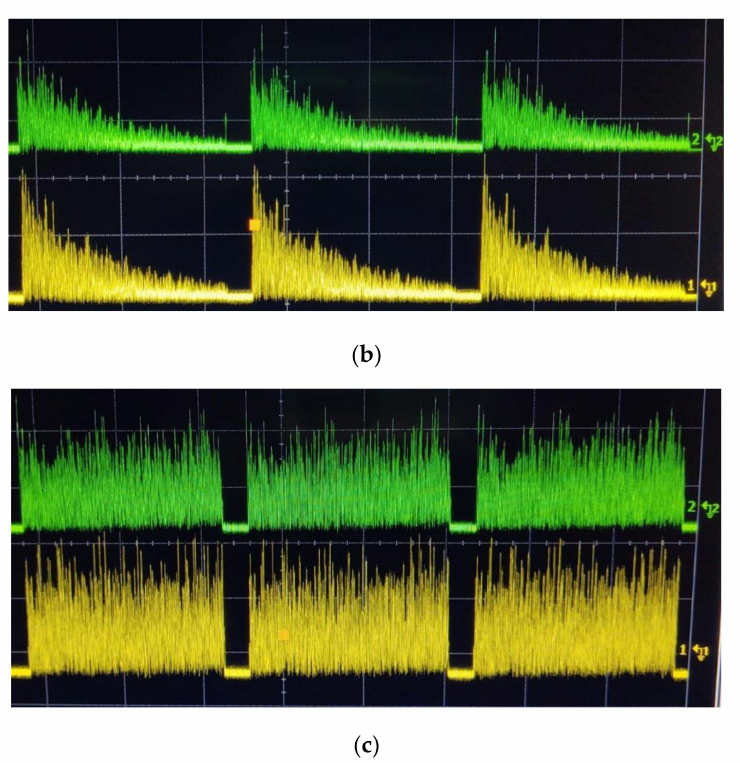
Figure 24. Two-fiber sensor signals obtained from two 50 km links: ( a ) signals at the outputs of o/e convertors, ( b ) signals after mixing and low-pass filtering without equalization, ( c ) equalized traces ready for A/D conversion.